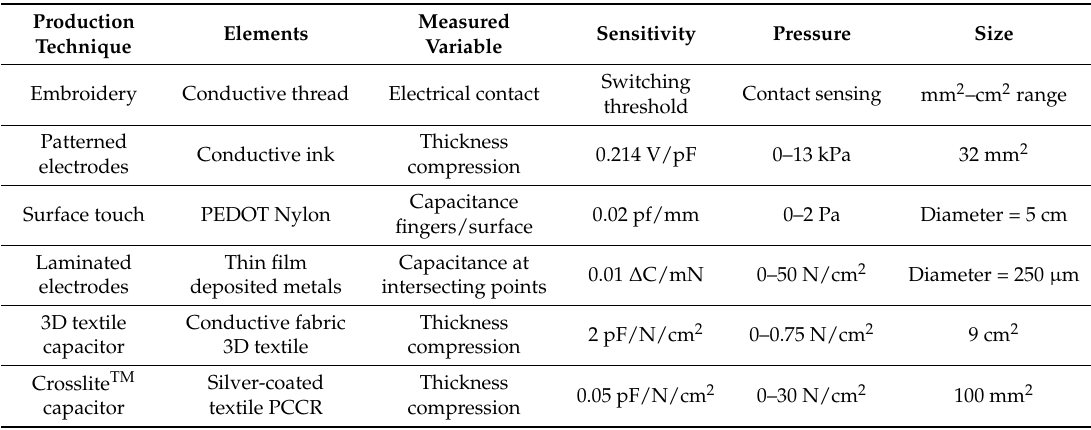
Table 3. Fabric capacitor pressure sensor production techniques [48].